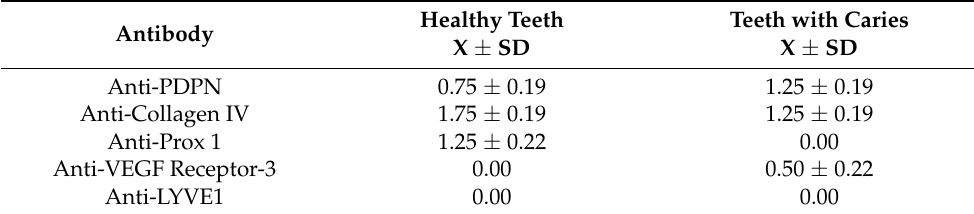
Figure 19. Light microscope image. Carious tooth. LYVE1—negative. Mag. 400 × . Table 3. Staining scale scores for specific antibodies.